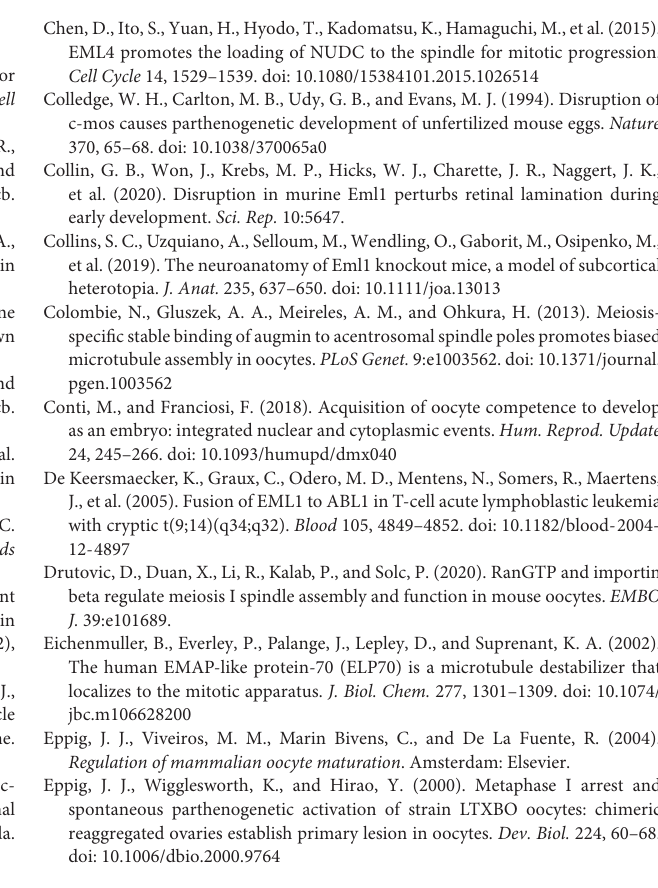
Supplementary Figure 1 | Expression and localization of C-terminal tagged EML1 - 3DDK fusion protein in HEK293T cell line during mitosis. (A) Western Blot (WB) analysis of the expression of EML1, FLAG and ACTB (internal control) protein in lysate from HEK293T cells transfected with Eml1 -3DDK plasmid DNA for 24 h. (B) Confocal micrographs showing the dynamic co-localization of EML1-3DDK fusion protein with spindles in HET293T cells during mitosis. FLAG and α -tubulin were stained in Red and green, respectively, while chromosomes were stained in blue. Scale Bar = 10 µ m. Supplementary Figure 2 | C-terminal tagged EML1 - 3DDK fusion protein showed the same special localization in mouse oocyte during meiosis progression with EML1 antibody. Oocytes microinjected with Eml1 -3DDK mRNA were first maintained at GV stage for 12 h, and then transferred to maturation medium. Confocal micrographs showing the dynamic co-localization of EML1-3DDK protein with meiotic spindles in oocytes at various stages (i.e., GV, Pro-MI, MI, AI, TI, and MII) of maturation. FLAG and α -tubulin were stained in Red and green, respectively, while chromosomes were stained in blue. The far left panel shows the whole-oocyte view of the staining. The magnified view of the boxed area within the oocyte at each stage is listed on the right side. Scale Bar = 20 µ